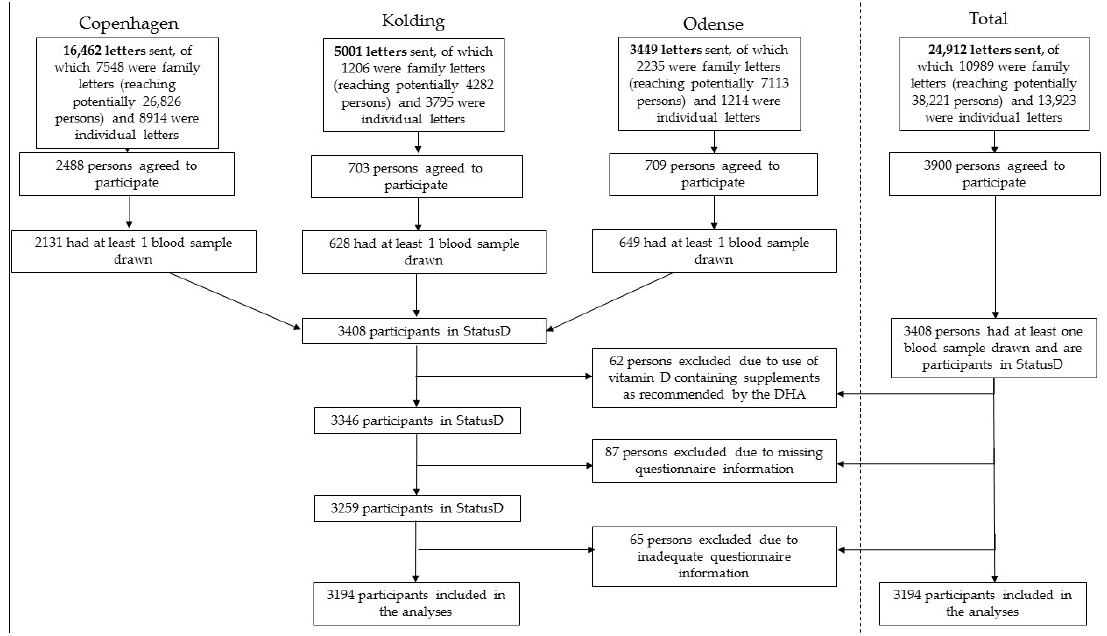
Figure 1. StatusD participant recruitment. DHA: Danish Health Authority.